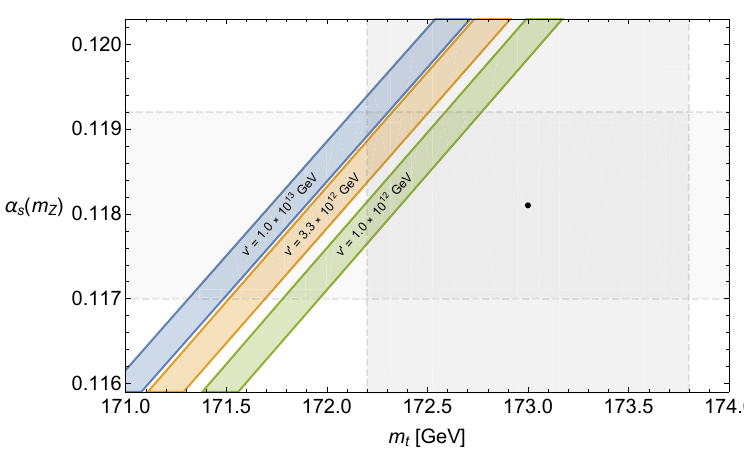
Figure 3 . The prediction for v is due to the uncertainty in the Higgs boson mass. The gray shaded rectangles show the current experimental values for m will hone in on v